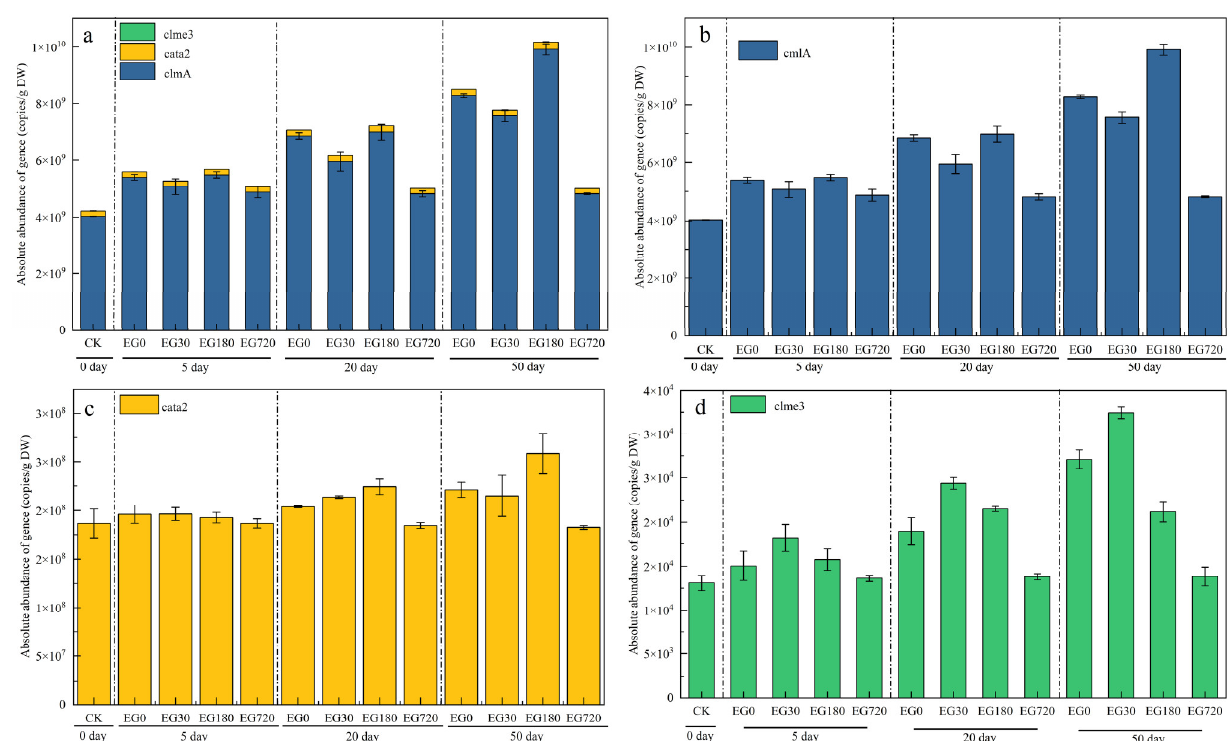
Figure 8. Changes in the absolute abundance of ( a ) the cmlA , cmle3 , and cata2 genes, ( b ) the cmlA gene alone, ( c ) the cata2 gene alone, and ( d ) the cmle3 gene alone.